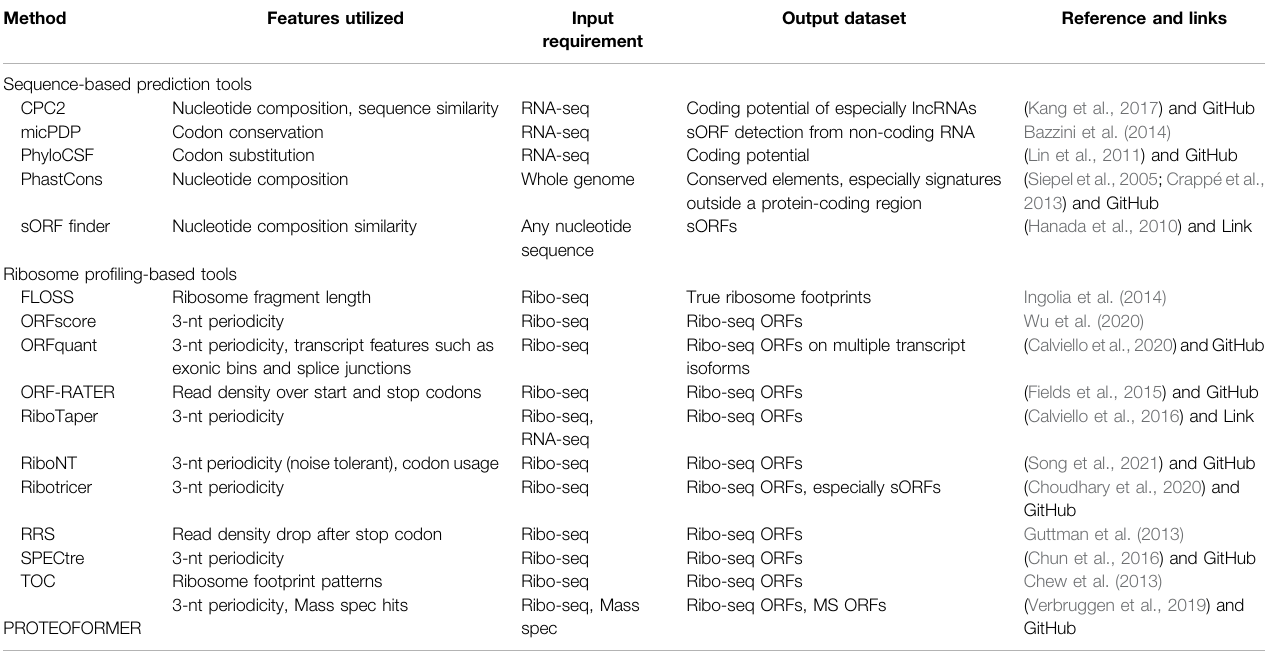
TABLE 3 | Overview of the computational tools aiding in the prediction of